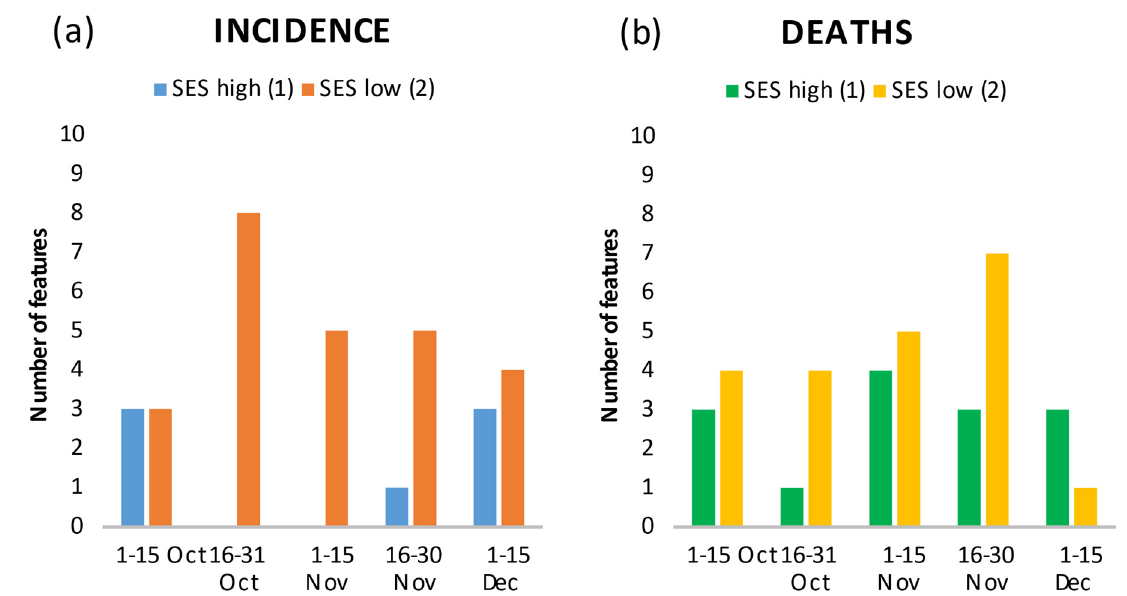
Figure 2. Number of features in the top 20 showing the relationship between low and high SES, and incidence ( a ) and death rates ( b ) by time period.